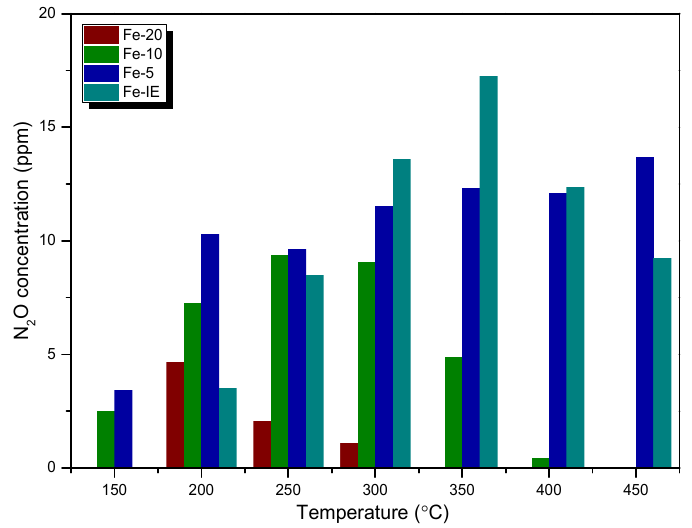
Figure 2. N 2 O concentration during the catalytic tests performed over the fresh